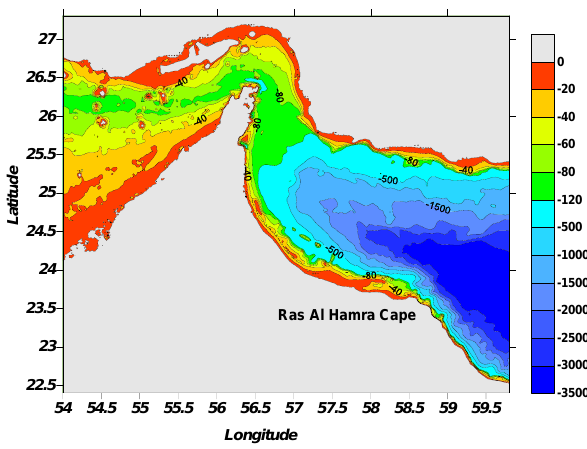
Fig. 1. The modelling domain and topography including east of Persian Gulf and the Oman Sea.